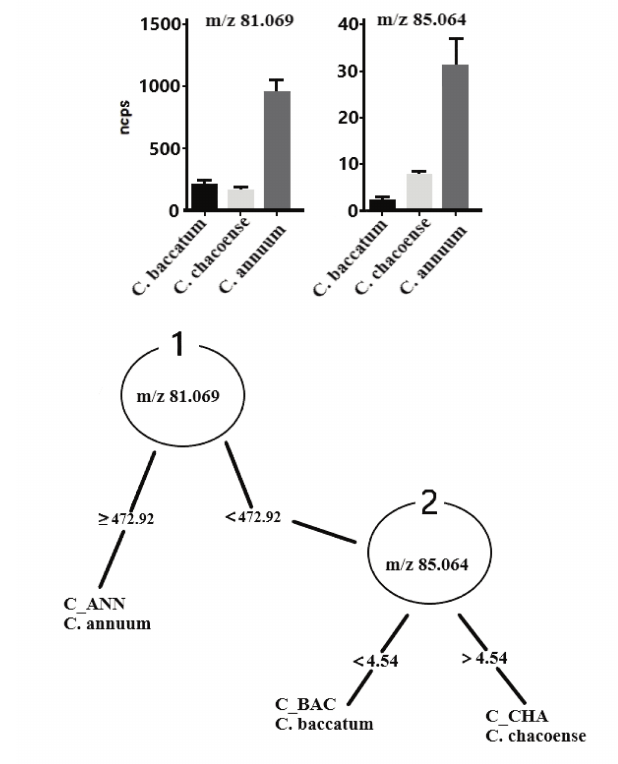
Fig. 3 ­ On the top the VOCs signal of the two most significant masses that help the identification of the species using a decision tree learning tool (n=10; SD). On the bottom, the two significant nodes have been